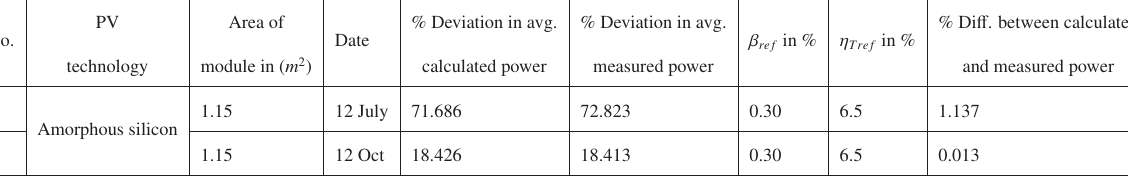
Table 3: Calculated photovoltaic module power for a-Si / thin film technology module. Sr. No.